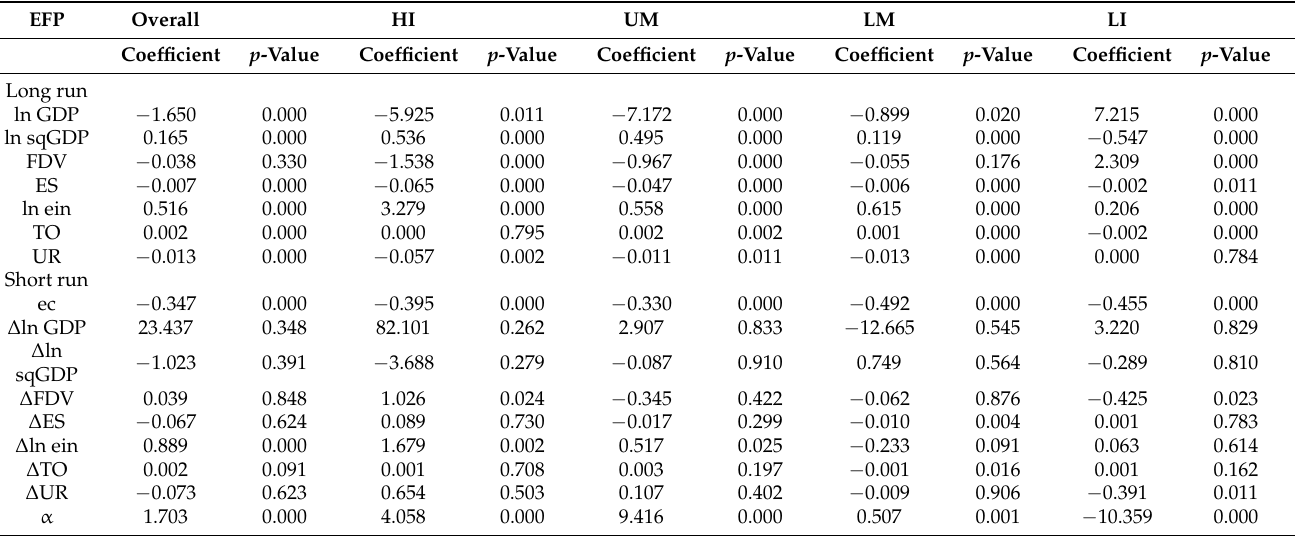
Table 7. (Model 2): The long and short-run relation between EFP and ln GDP, ln GDP square, FDV, ES ln ein, TO,